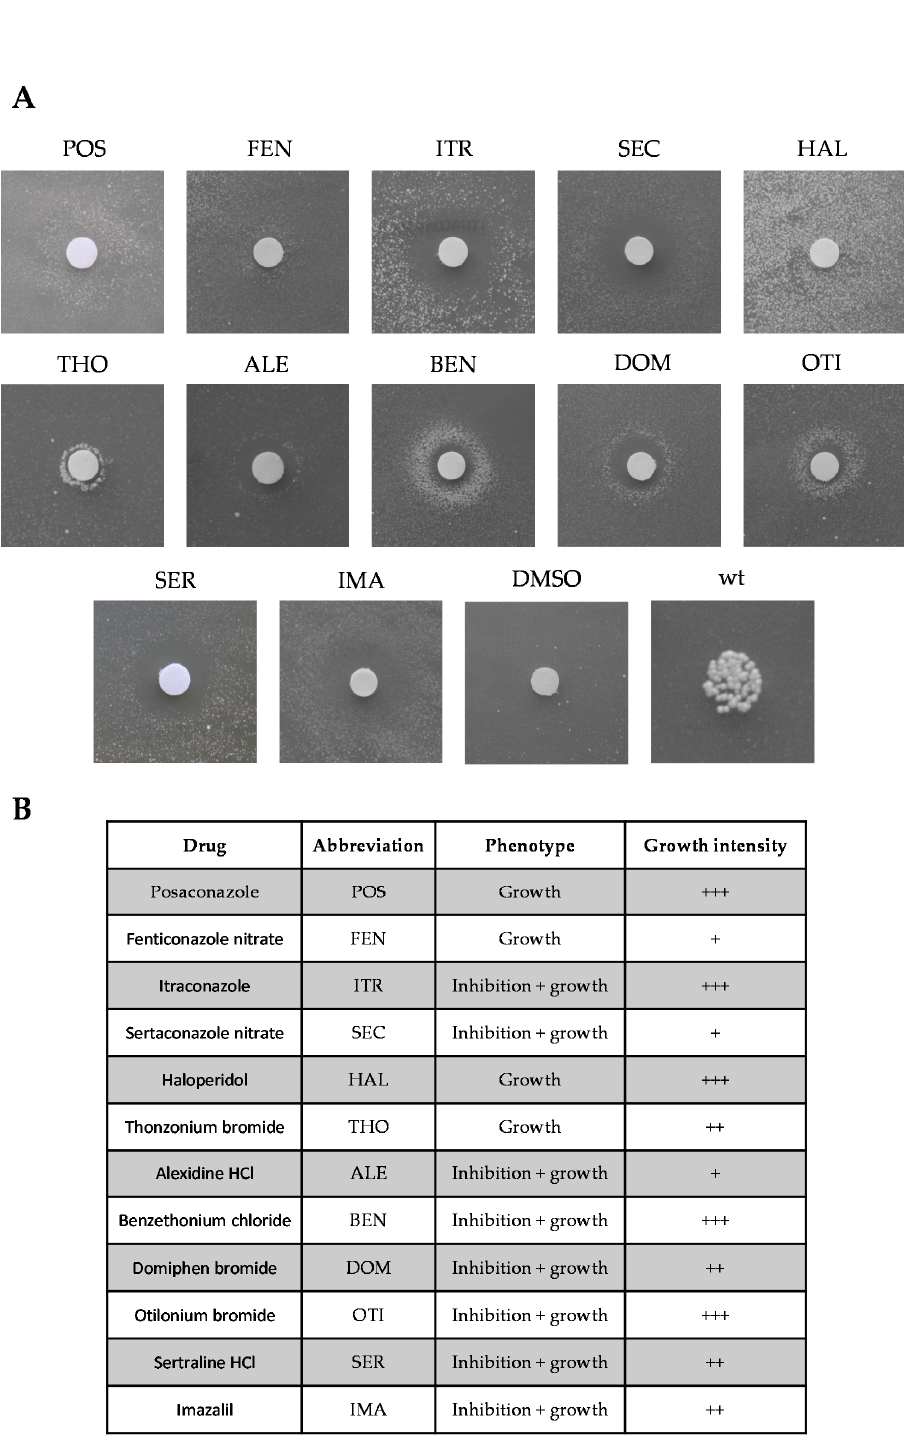
Figure 1. Identification of drugs rescuing the defective oxidative growth of the s ym1 R51W mutant strain. ( A ) 1.5 × 10 5 cells were spread on a 12 × 12 cm square plate containing solid YP